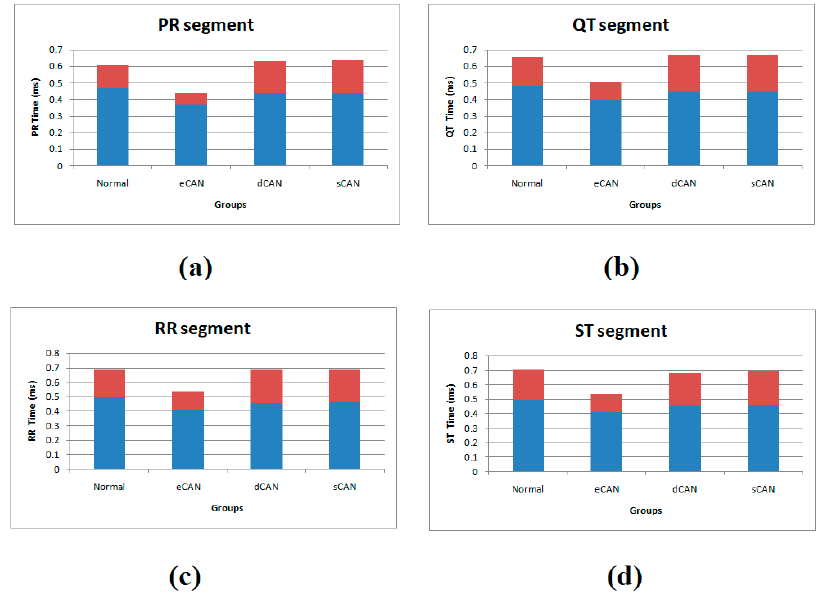
Figure 7. Mean (blue) and SD value (red) of time intervals of different segments: ( a ) PR segment, ( b ) QT segment, ( c ) RR segment, and ( d ) ST segment for the entire 20 min recording. In the second test, the mean and SD of FD values of segments at intervals (1–5th, Table 3. p ‐ value from the Kruskal–Wallis test for the whole 20 min. 6–10th, 11–15th, and 16–20th minute) for the four ECG segments for all groups are shown in Figure 8.